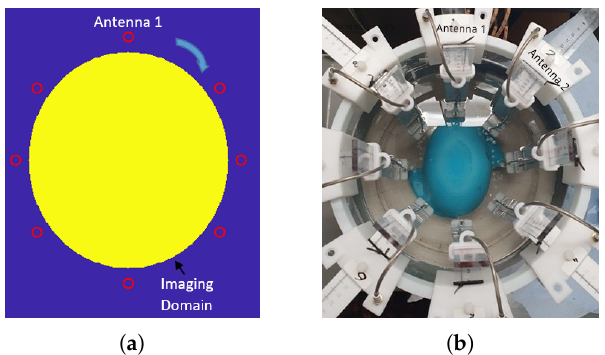
Figure 4. ( a ) Schematic of the simplified “initial guess” model for the inversion (the ellipsoid’s axes are 153 mm and 112 mm long); ( b ) The hardware system